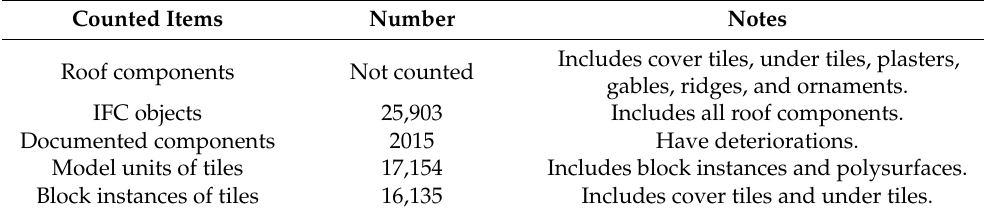
Table 1. The statistics of the roof.